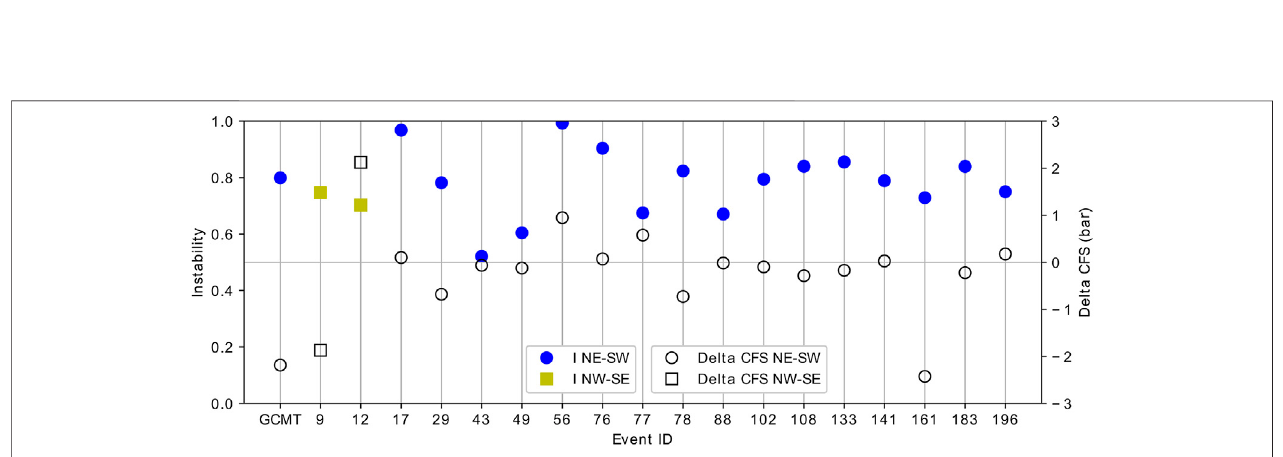
FIGURE 11 | Comparison of instability and Δ CFS of Pidie Jaya aftershocks nodal planes. All events, except events 9 and 12, are plotted using their NE-SW instability and Δ CFS results. Both instability and Δ CFS calculation used a friction coef fi cient of 0.32.